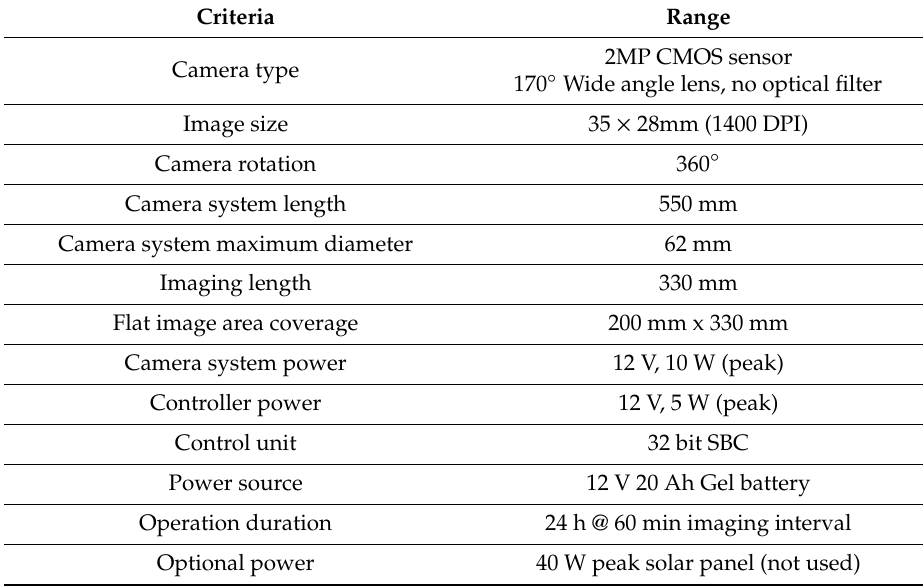
Table 3. Specification of the prototype of the proposed